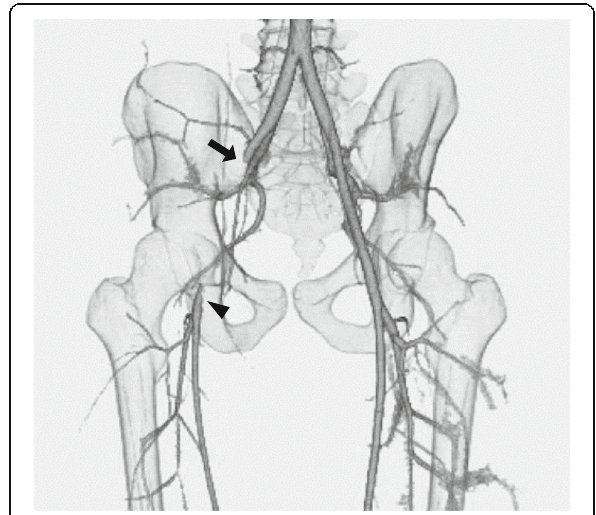
Fig. 1 Preoperative CT angiography shows occlusion extending from the right EIA to CFA (arrow) and a contrast effect peripheral to the lesion from collateral circulation (arrowhead). CT, computed tomography; EIA, external iliac artery; CFA, common femoral artery